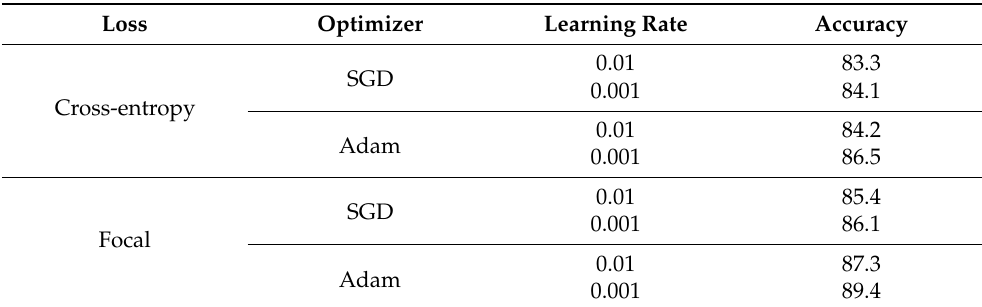
Table 1. Model performance comparison using different combinations of hyperparameters, including loss function, optimizer, and learning rate.